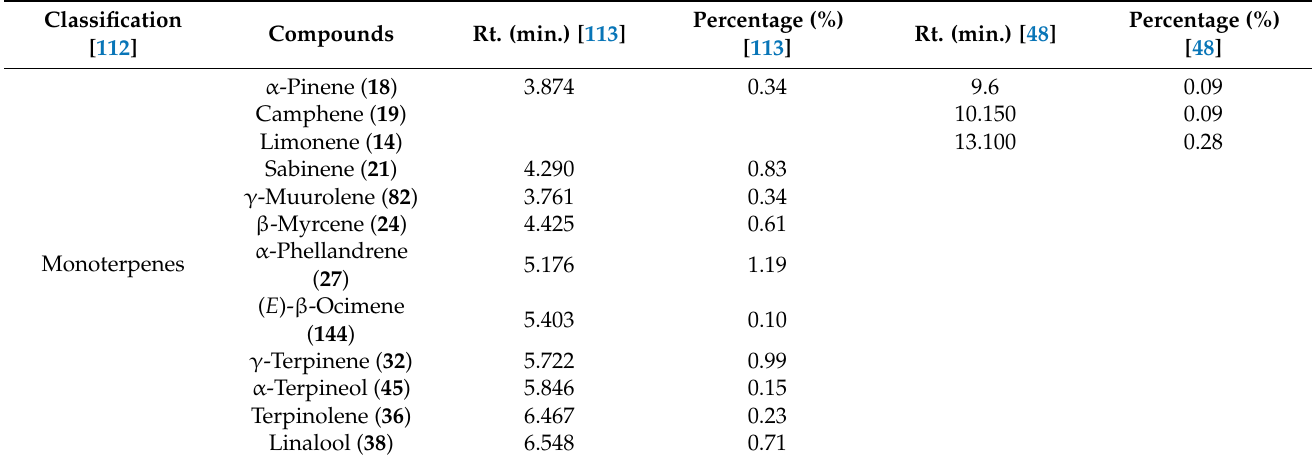
Table 3. List of isolated bioactive compounds identified from leaves extract of P. betle